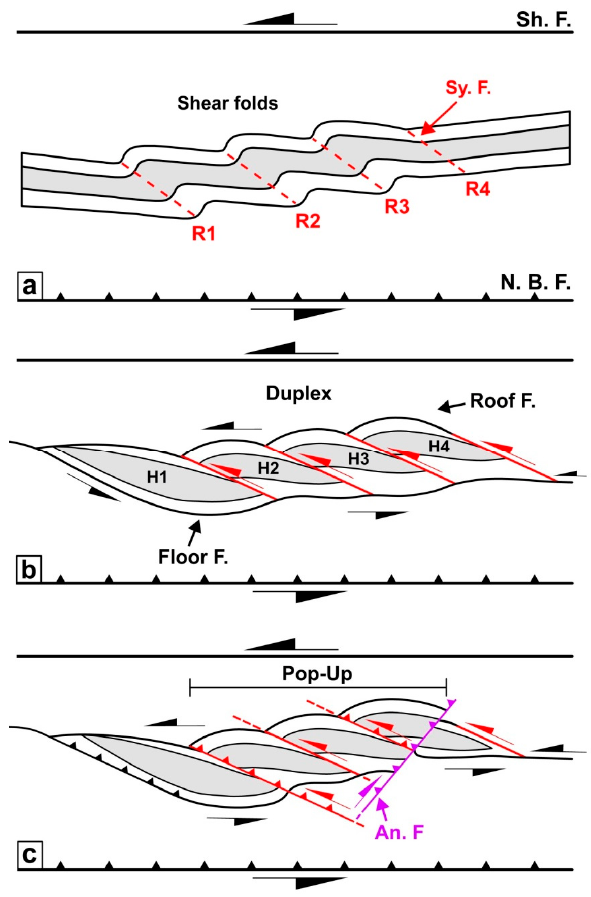
Figure 18. The proposed structural model for the duplex and pop-up structures within the Shekarab transpressional zone. ( a ) Formation of the shear folds with the NW-SE axes within the shear zone. ( b ) Displacement of the folded units along the fold axes (as the synthetic faults) and along the floor and roof faults. H and R with numbers are the horse and ramp of the duplex, respectively. ( c ) Formation of the pop-up structure on the hanging-walls of the ramp 1 and antithetic fault (An. F). In the left-lateral Shekarab duplex, the recent shear folds and displacement of rock units along the fold axes are recorded (Figure 14). This duplex at the first stages of the progressive deformation could be assumed to be a shear fold with a NW-SE axis (Figure 18a). Later, the folded units are displaced along the fold axis and the E-W faults (as the roof and floor faults) in the center of the shear zone (Figure 18b). The low to moderately